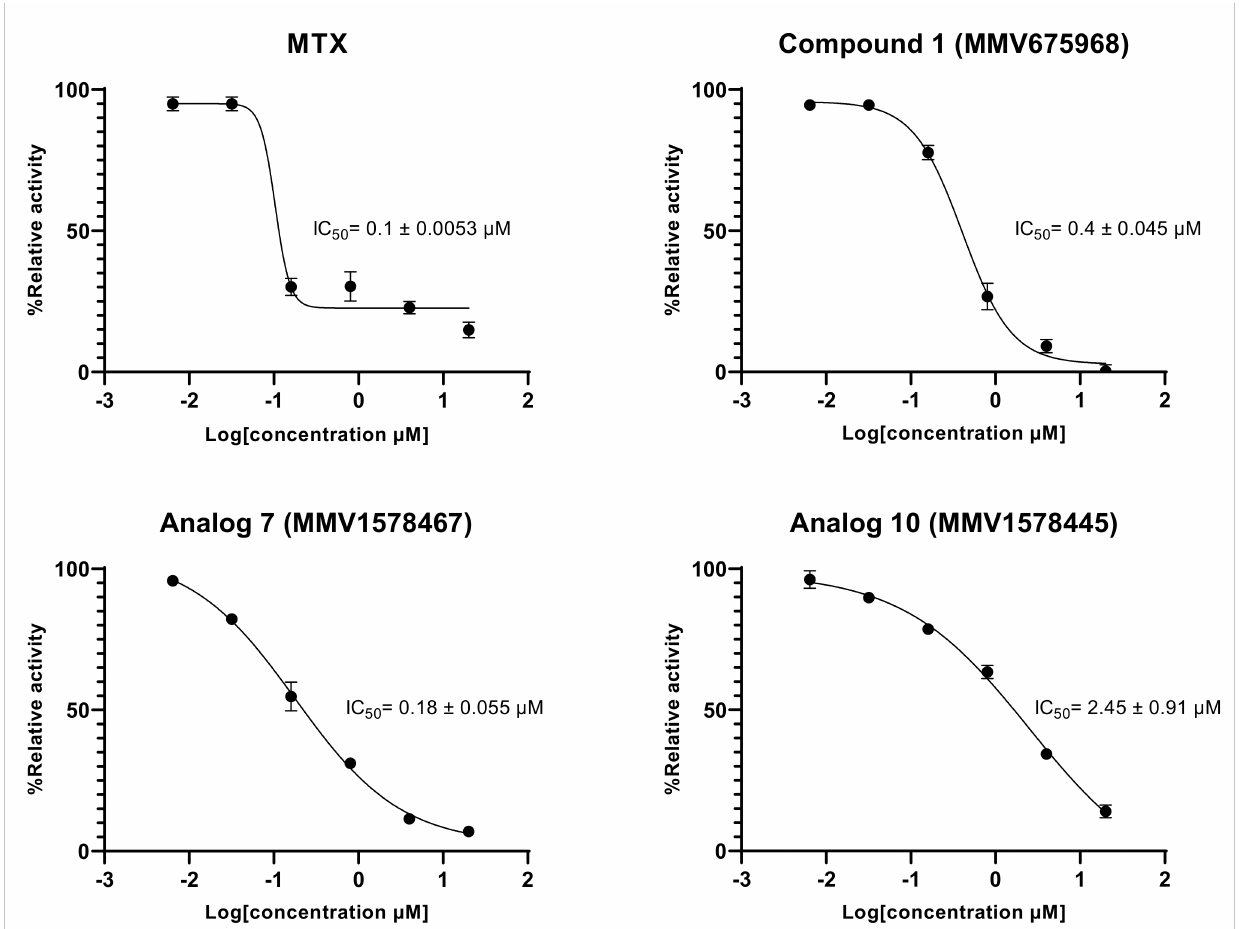
Figure 7. In vitro concentration-dependent effect of inhibitors on the predicted T. b. b. DHFR enzyme activity. Six-point fivefold diluted concentrations of compounds ranging from 20 to 0.00064 µ M were tested in the in vitro enzymatic assay. Experiments were performed in duplicate and mean absorbance counts were normalized to percent T. b. b. protein control activity using Microsoft Excel. Concentration–response curves were generated using GraphPad Prism